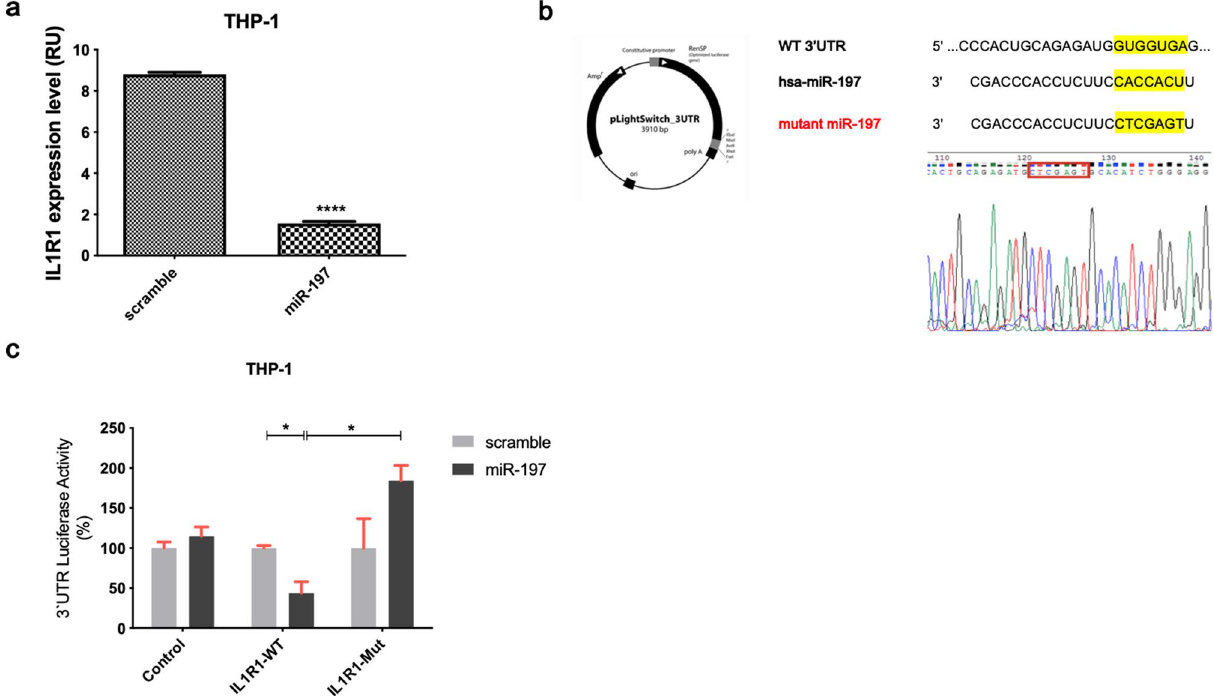
Figure 5. miR-197-3p targets IL1R1 in THP-1 cell line. (a) Analysis of IL1R1 expression by qCPR in cells on overexpression of miR-197. Data represent the mean ± standard deviation from three independent experiments. **** P < 0.0001, Student’s t-test (two-tailed). ( b) miR-197-binding site in IL1R1 3 ′ UTR and the sequences of wild-type (WT) and mutant IL1R1 3 ′ UTR in 3 ′ UTR plasmid used in the 3 ′ UTR luciferase experiments are shown. The mutated sequence is indicated by a red frame. Wild sequence: GTG GTG A, Mutant sequence: CTC GAG T. ( c) WT IL1R1 3 ′ UTR and Mut IL1R1 3 ′ UTR reporter were constructed, and a luciferase reporter assay was performed in THP-1 cells after miR-197-3p transfection. Data represent the mean ± standard deviation from three independent experiments. * P < 0.05, Student’s t-test